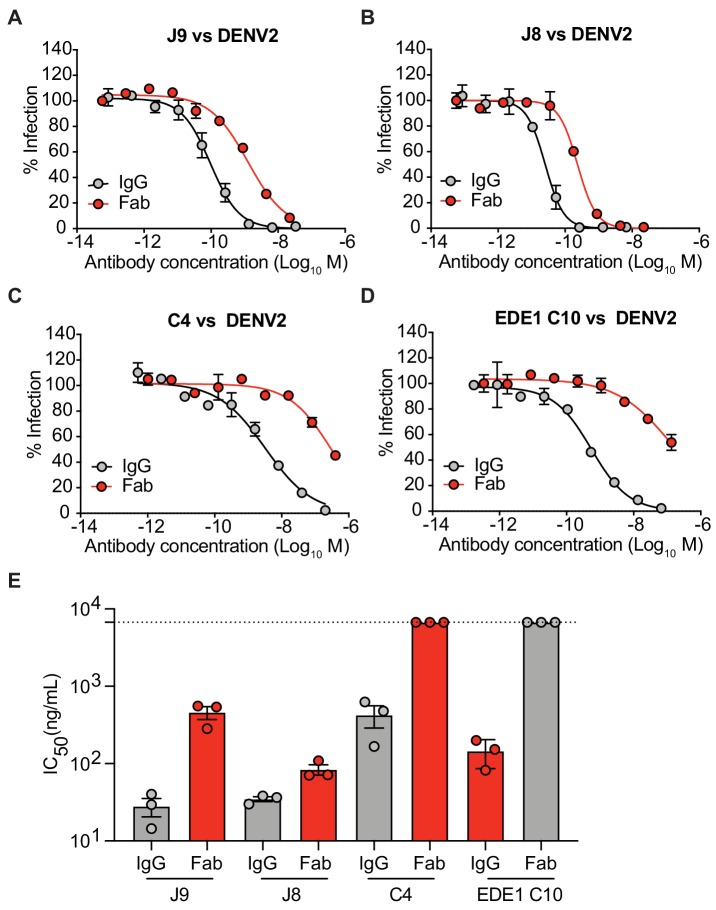
Neutralization potency of IgG and Fab fragments.(A) J9, (B) J8, (C) C4, and (D) EDE1 C10 were tested as Fab fragments or full-length IgG for neutralization of DENV2 reporter virus. Dose-response neutralization curves represent three independent experiments, each performed in duplicate. Data points and error bars indicate the mean and range of duplicate wells, respectively. (E) Mean IC50 values of the indicated IgG or Fab fragment from three independent experiments represented by data points. Error bars represent the SD. Values at the dotted horizontal line indicates that 50% neutralization was not achieved at the highest concentration of Fab tested. Fabs were tested at 2x excess molar concentration relative to IgG.